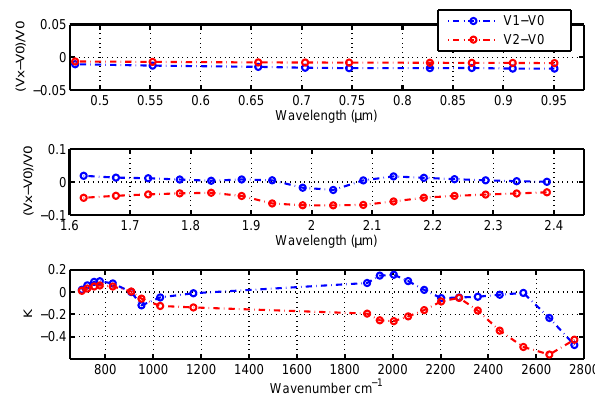
Fig. 19. Comparison between radiance simulated for cases V0, V1, V2 for Sector 1. Top and middle panels: fractional radiance dif- ference with respect to V0; lower panel: brightness temperature difference with respect to V0.